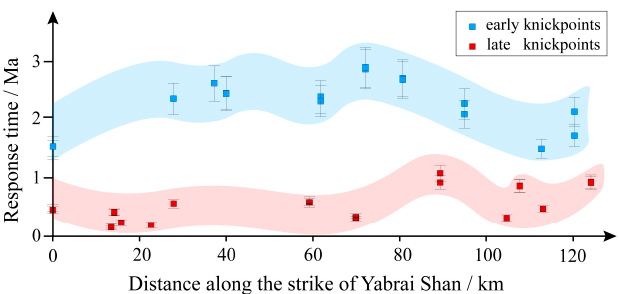
Figure 14. Geomorphic response times of the two-phase knickpoints in Yabrai Shan. The blue and red points indicate the early and late knickpoints, respectively.